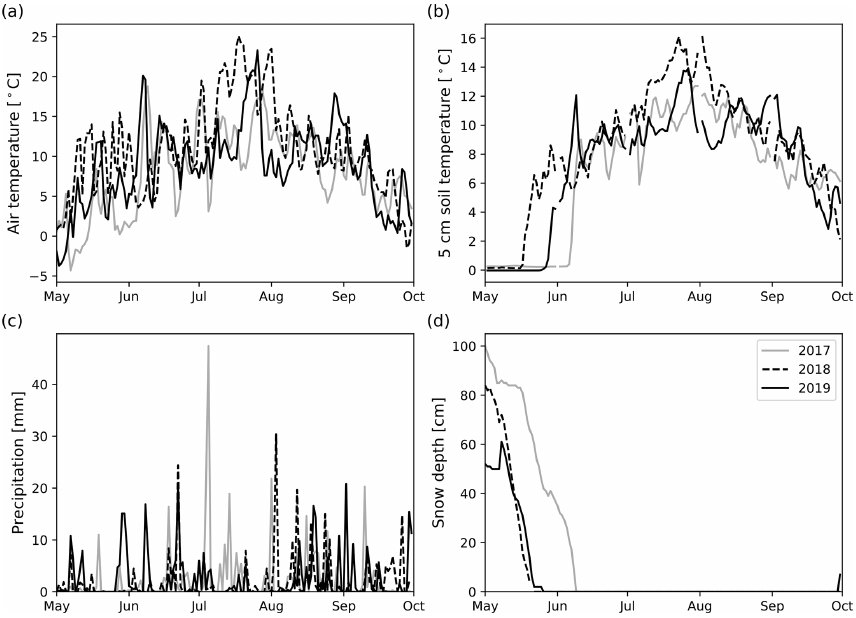
Figure 2. Daily mean air temperature (a) , daily mean 5cm soil temperature (b) , daily precipitation sum (c) , and daily snow depth (d) measured at Kenttärova weather station in May to September 2017–2019.